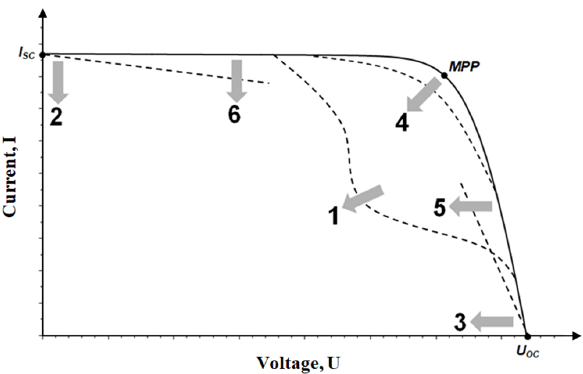
Figure 2. Anomalies in the course of I–V characteristics of the PV module. Possible deformations of the graphs are marked with arrows from 1 to 6. graphs are marked with arrows from 1 to